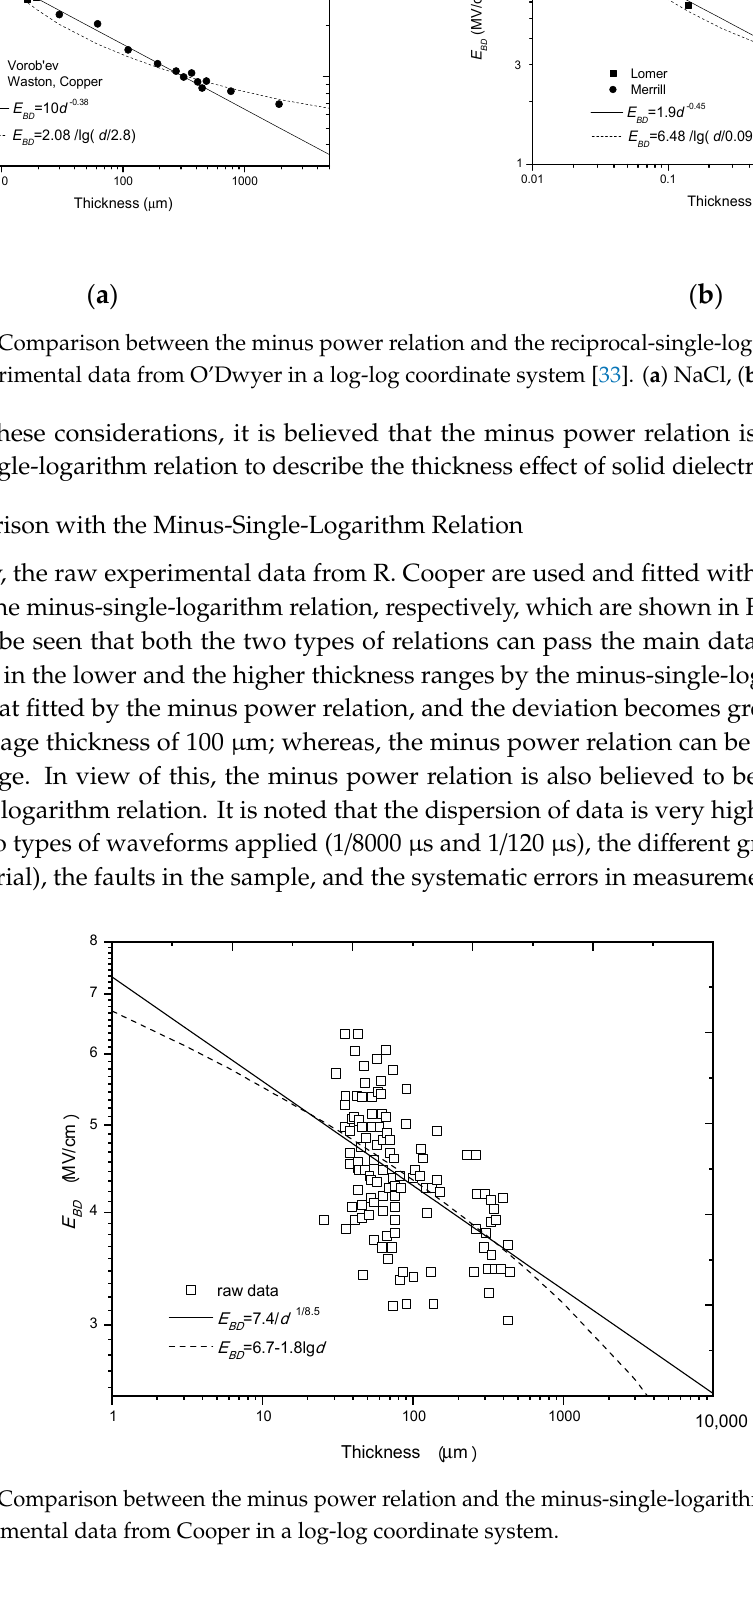
( b ) Figure 6. Comparison between the minus power relation and the reciprocal-single-logarithm relation with raw data from Austen [30]. ( a ) Two types of fitting in a linear coordinate system, ( b ) two types of fitting in a log-log coordinate system. Aside from the experimental data from Austen, the data from O’Dwyer are also compared, as shown in Figure 7a,b. From these two figures, it can be seen that the minus power relation gives a better fit in all the data ranges, whereas the reciprocal-single-logarithm relation can only cover parts of